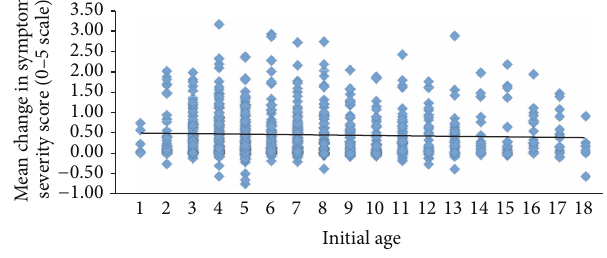
Figure 5: Mean change in symptom severity score as a function of initial age ( R 2 = 0.002). Symptom severity score was the change on